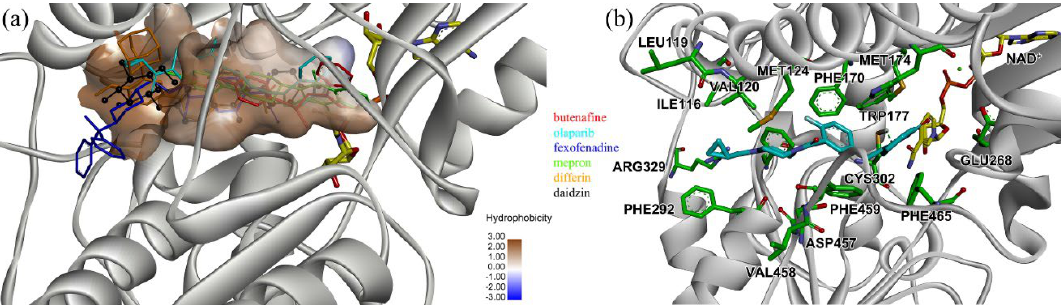
Figure 3. ( a ) Binding poses of ALDH2 with selected inhibitors from docking and ( b ) representative binding mode of ALDH2 with olaparib from MD simulations. Five compounds (butenafine, olaparib, fexofenadine, mepron, and differin) are chosen as potential inhibitors and are shown with the stick models in different colors ( a ). The pose of daidzin (colored in black) in the crystal structure (PDB code: 2VLE) is displayed with the scaled ball and stick model for reference ( a ). The hydrophobic surface on the receptor is created using the ALDH2–daidzin binding pose to depict the hydrophobic tunnel for ligand binding ( a ). Carbon atoms of olaparib in the complex with ALDH2 are colored in cyan, while the carbon atoms of interacting receptor residues are in green ( b ). The cofactor NAD + is shown by the stick model with its carbon atoms in yellow, and the green ball in the panel ( b ) is Mg 2+ ion bound to NAD + . Hydrogen atoms are removed for clarity. Table 3. Time-averaged root-mean-square deviation (RMSD) of protein backbone atoms and receptor- ligand binding energies ( ∆ E bind ) for the ALDH2 tetramer and monomers.